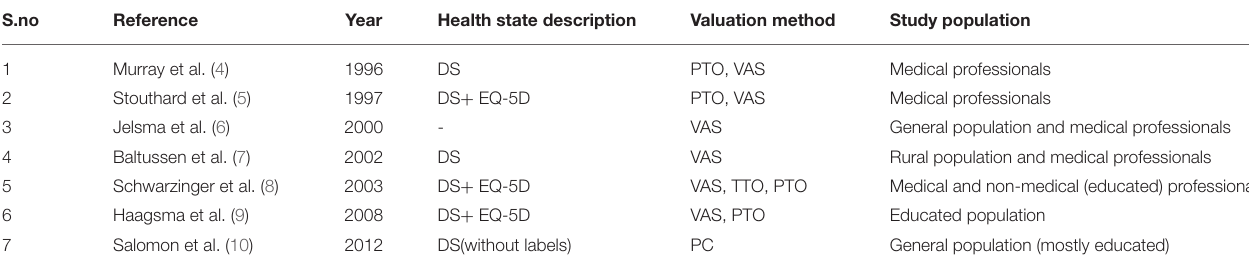
TABLE 1 | List of various health state valuation studies conducted across the globe and the valuation methods used. S.no